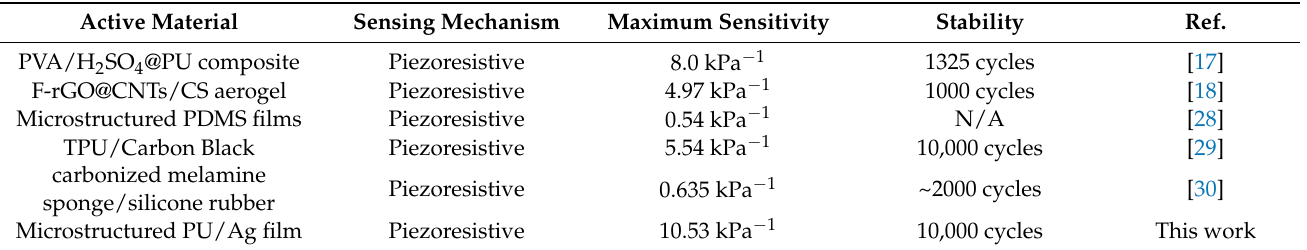
Table 1. A Comparison of some piezoresistive pressure sensors reported recently with the proposed sensor.